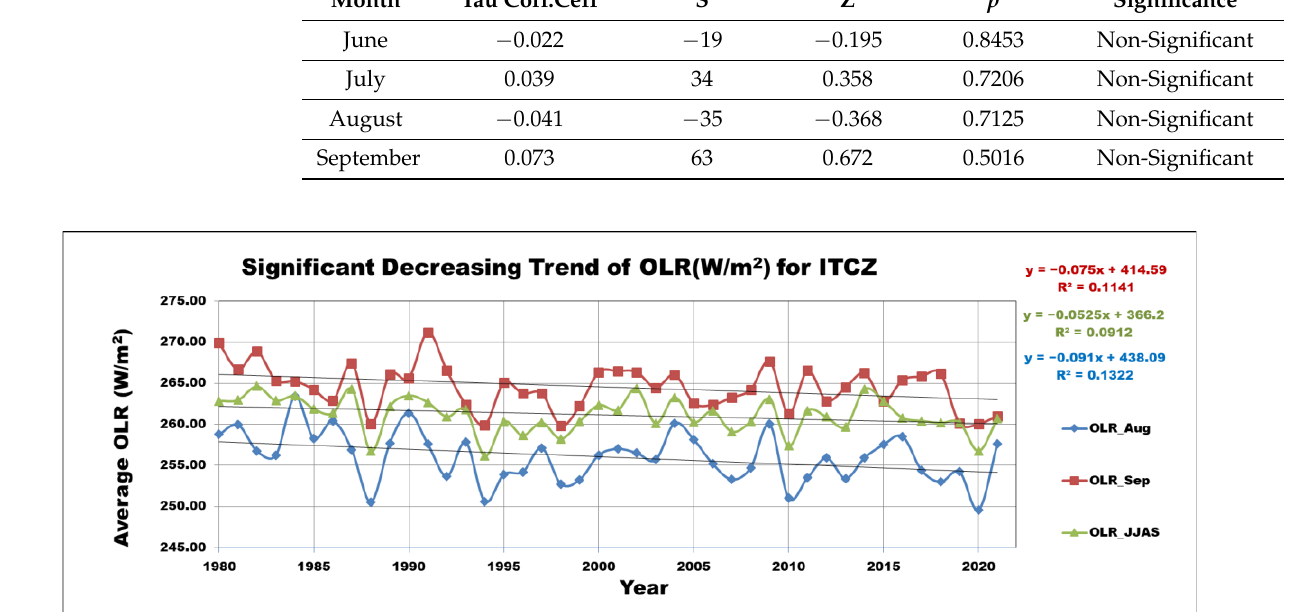
Table 4. Mann Kendall Trend Test of OLR in W/m 2 for HCIO zone monthly.